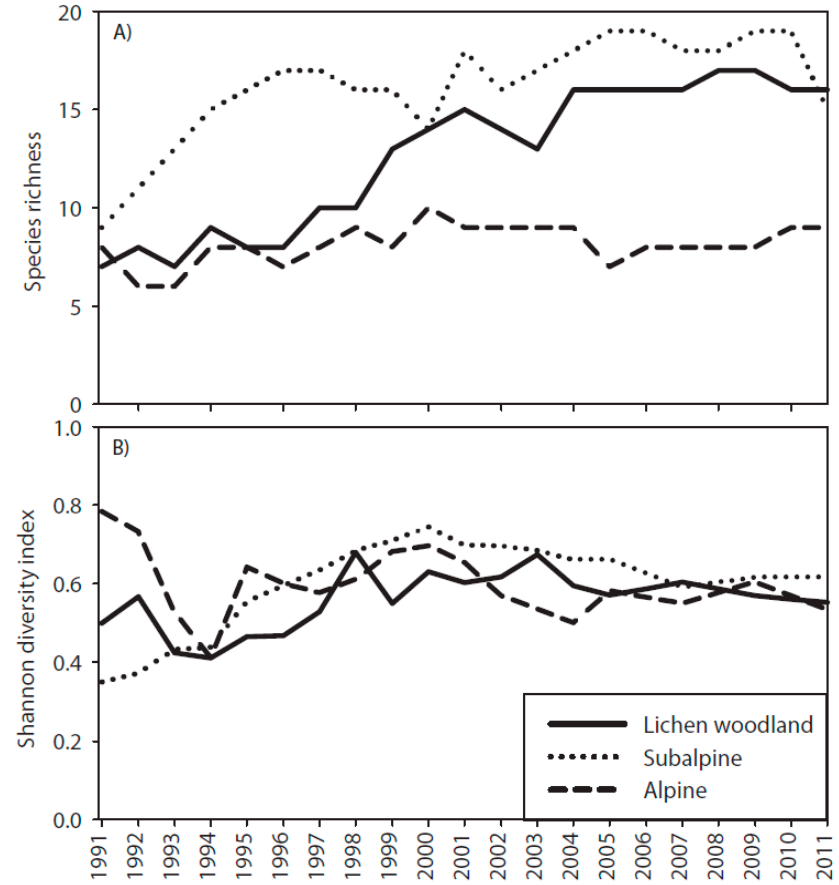
Figure 6. Species richness ( A ) and Shannon diversity index ( B ) of lichen woodland (solid line), subalpine (dotted line) and alpine (dashed line) sites.